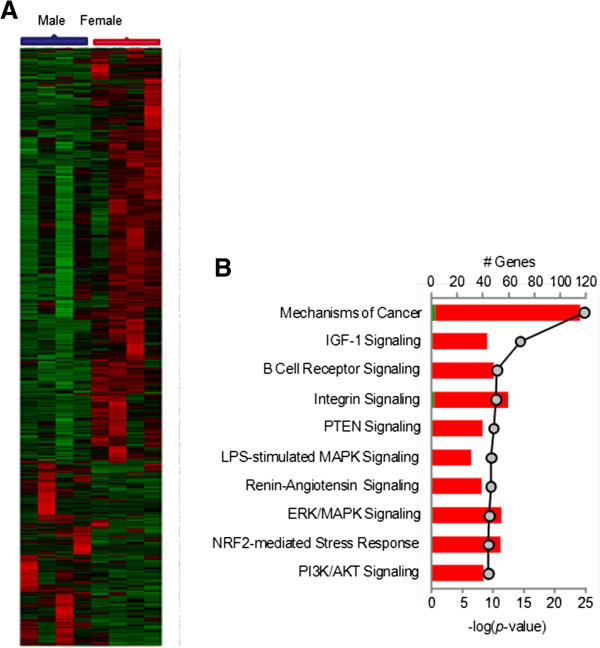
The microenvironment of the gut in women has a transcriptional profile indicative of increased activation and turnover. Transcriptional analysis of jejunal mucosa was performed using oligonucleotide microarray analysis. (A) All samples cluster in accordance with the gender of the participant. A large portion of the gene expression included genes that were upregulated in women as compared to men (B) The genes that were upregulated clustered into functional categories of IGF-1 signaling, Integrin Signaling and other signaling pathways (p<.05).